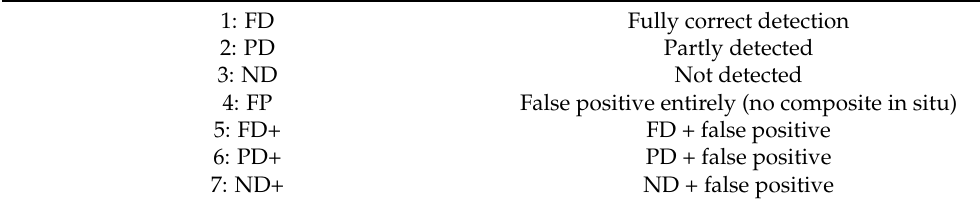
Table 1. Correctness of identification of the composite remnants (COI) scoring